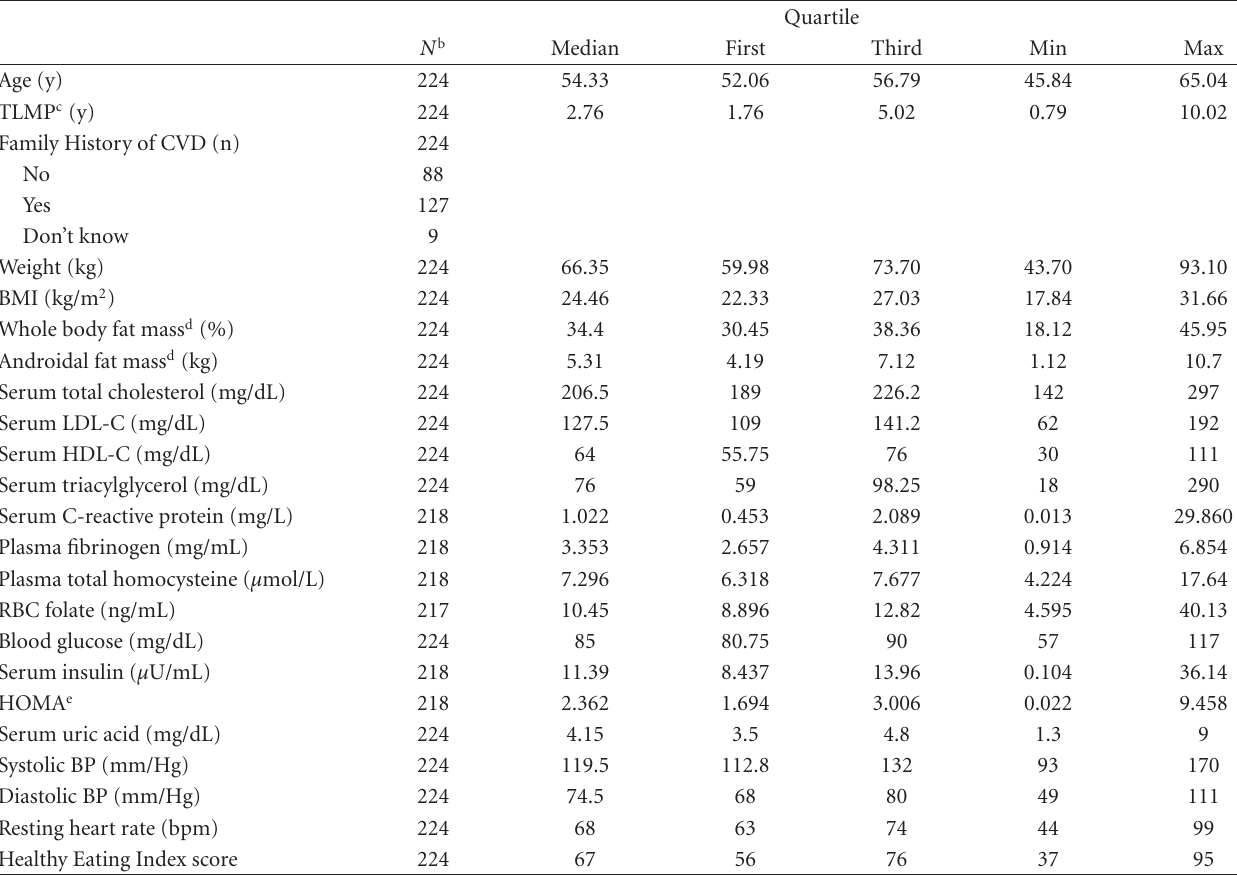
Table 1: Characteristics of participants at baseline a